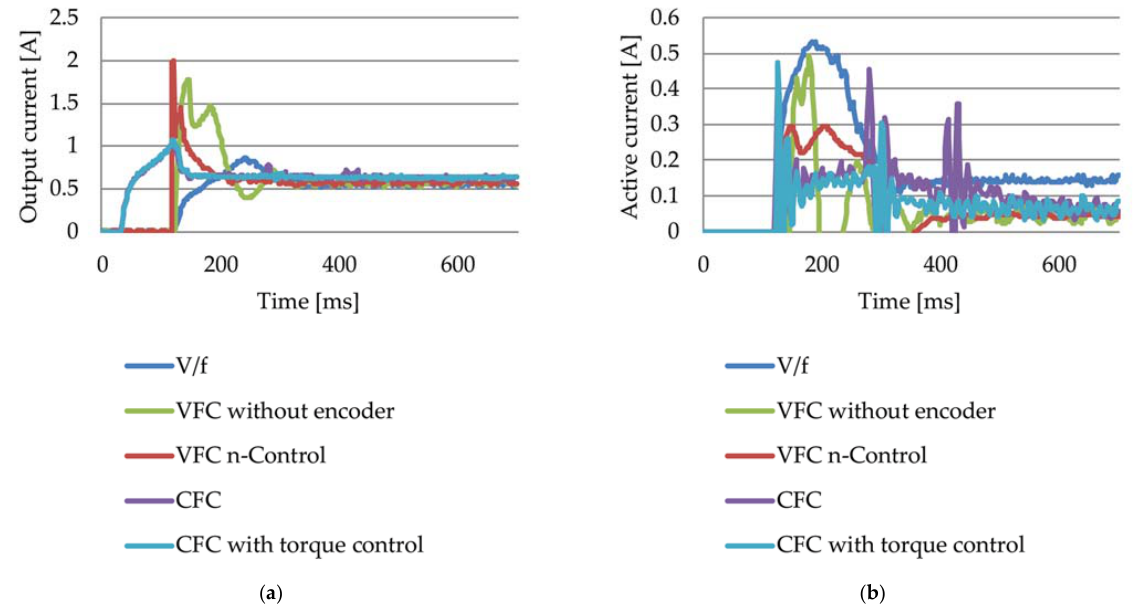
Figure 3. Comparison of: ( a ) output current intensity values (I O ) for various control modes, ( b ) active current intensity values (I A ) for various control modes.